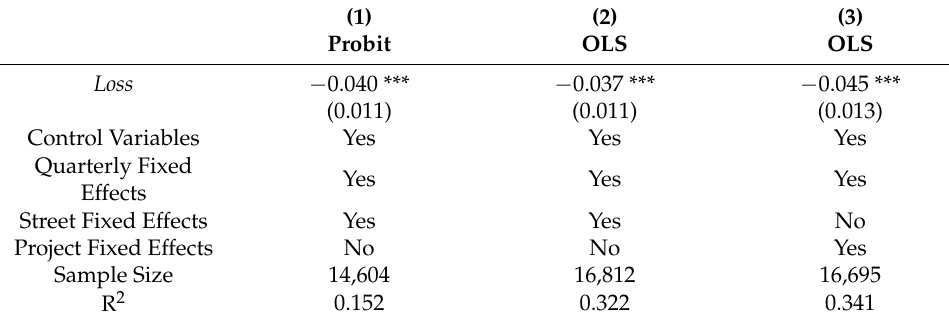
Table 6. Robustness analysis: limit the scope of purchase dates.